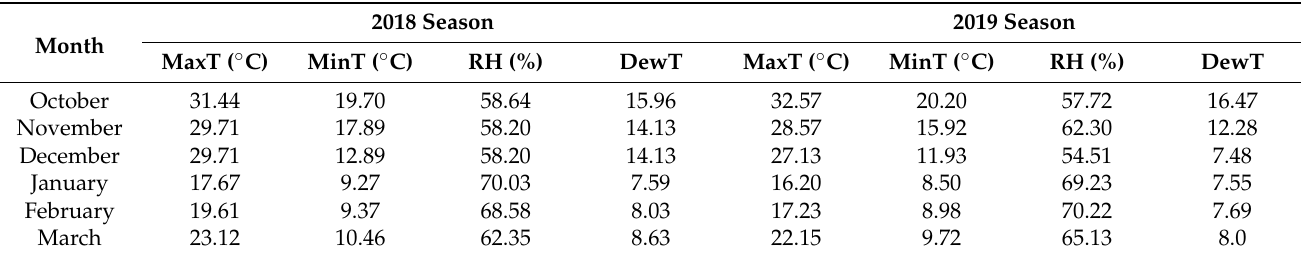
Table 3. Monthly meteorological data of the experimental site in 2018 and 2019